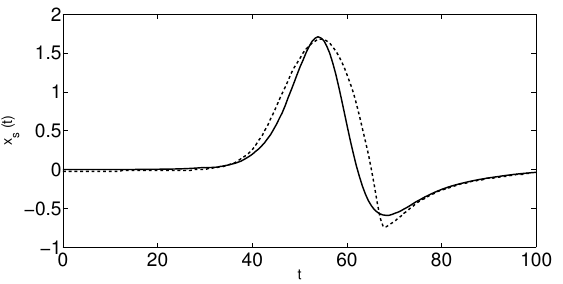
Figure 4. The shoreline movement of a solitary wave introduced in Synolakis (1987). The LSWE model coupled to the NSWE is shown by the dashed line, while the solid one is the shoreline movement of the LSWE model with an EBC implementation. Kristina et al.: Effective Coastal Boundary Conditions for Tsunami Wave Run-Up over Sloping Bathymetry